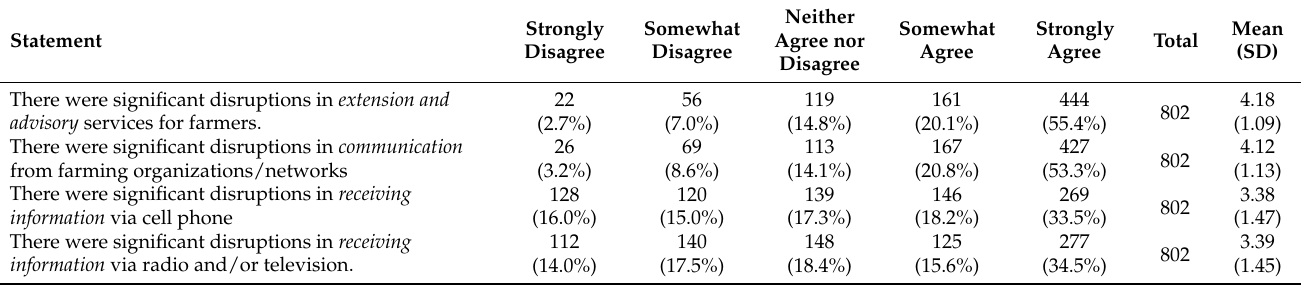
Table 12. Thinking about what occurred due to COVID-19, please indicate your level of agreement for each of the following